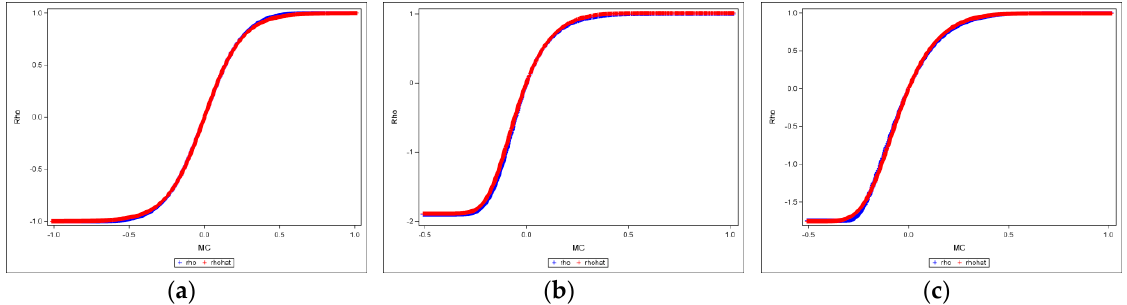
Figure 3. Fitted curves of the MC against ρ for 70-by-70 ( n = 4900 ) surface partitionings: ( a ) square rook case; ( b ) square queen case; and, ( c ) hexagonal case.